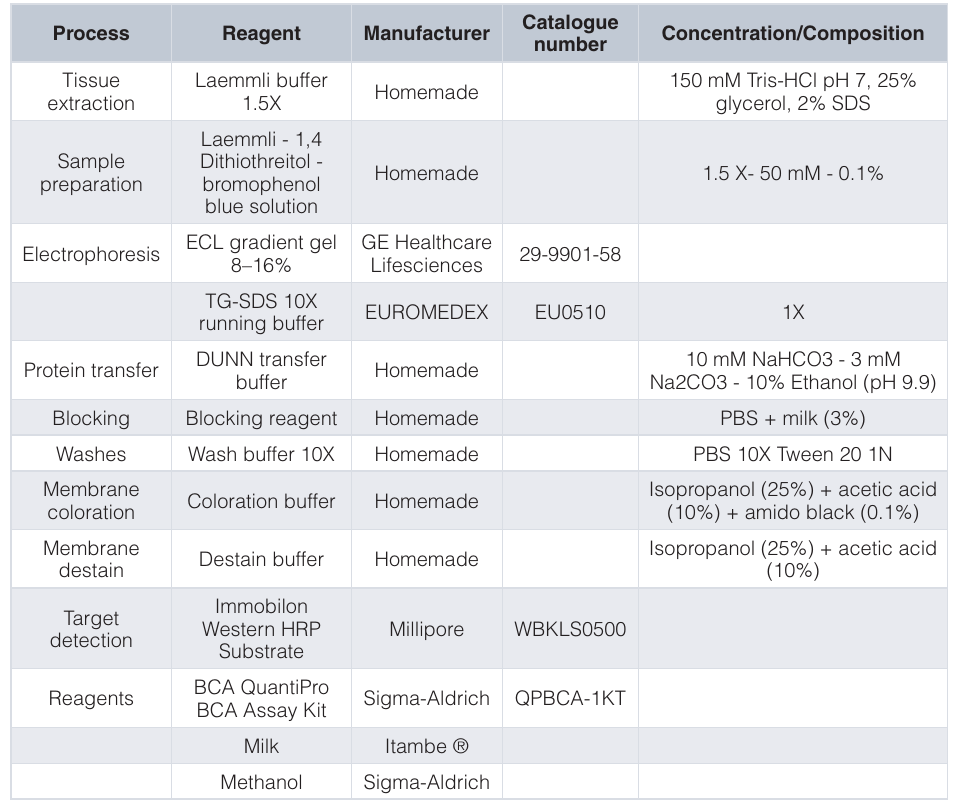
Table 2. Tissue extraction and western blot